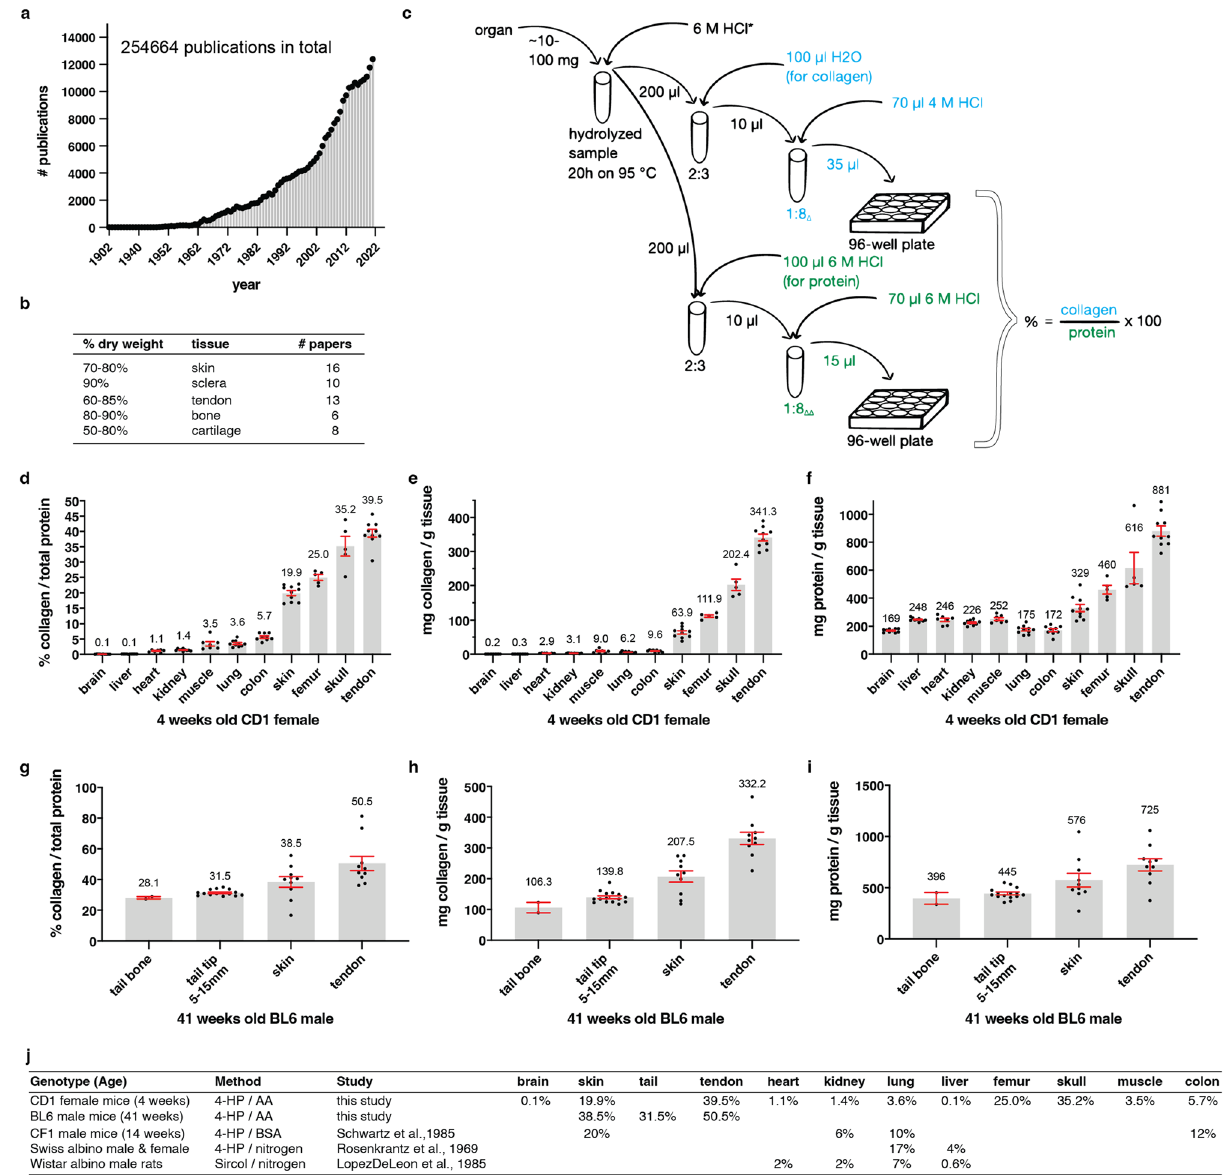
Figure 1. Relative collagen levels in organs. ( a ) number of publications per year about collagen. See Supplementary Table 1 for details. ( b ) Previous studies stating the percentage of collagen in organs normalized to dry weight. See Supplementary Table 2 for details. ( c ) Schematic representation of the collagen and protein quantification assay for organs. * indicates dilution calculation for organs: v = aw × D organ − aw (v = µL 6M HCl added to organs, aw = organ assay weight (mg), D organ = experimentally determined organ specific dilution factor). ∆ indicates that liver and brain collagen samples were diluted 1:1 and tendon collagen samples 1:16. ∆∆ indicates that liver and brain protein samples were diluted 1:10. ( d , g ) The percentage of collagen to the total protein of different CD1 female and C57BL/6 male organs, respectively, calculated as shown in ( c ). CD1 tissue is derived from 4 weeks old female mice, and C57BL/6 organs were withdrawn from 41 weeks old male mice. ( e , h ) collagen values normalized to wet weight (mg/g). ( f , i ) protein content normalized to wet weight (mg/g). ( d – i ) Means ± SEM of 2–15 biological replicates (represented by dots). Each biological replicate value was derived from 1 to 3 technical replicates, measured in duplicates. See Supplementary Tables 4 and 5 for details. ( j ) an overview of collagen content in different mouse strains and species. See Supplementary Table 5 for